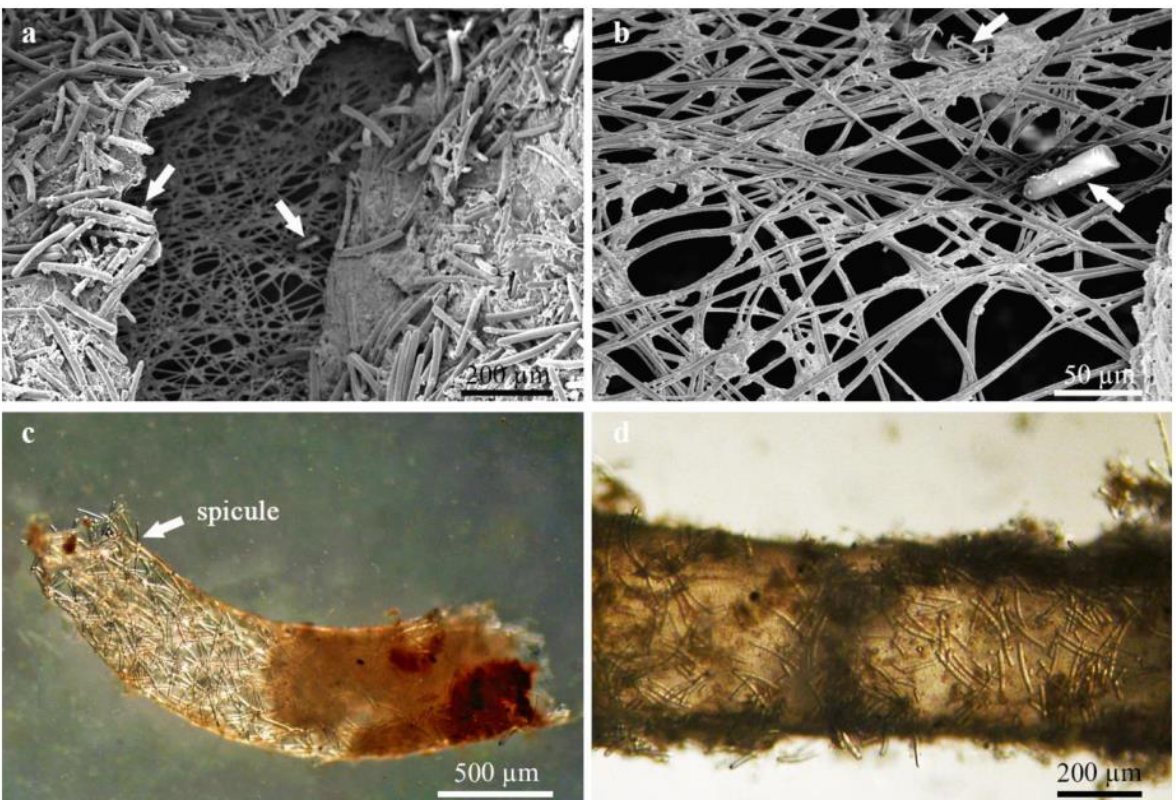
Figure 4. Corvospongilla siamensis morphology (Pong River, Lower Mekong). ( a , b ) Heterogeneous microhabitat at the sponge irregular surface with ridges and large tube-like exhalant aquiferous aperture openings.